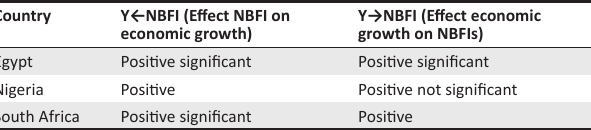
TABLE 6: Summary of findings in respect of the relationship between non-bank financial institutions and economic growth in Egypt, Nigeria and South Africa.